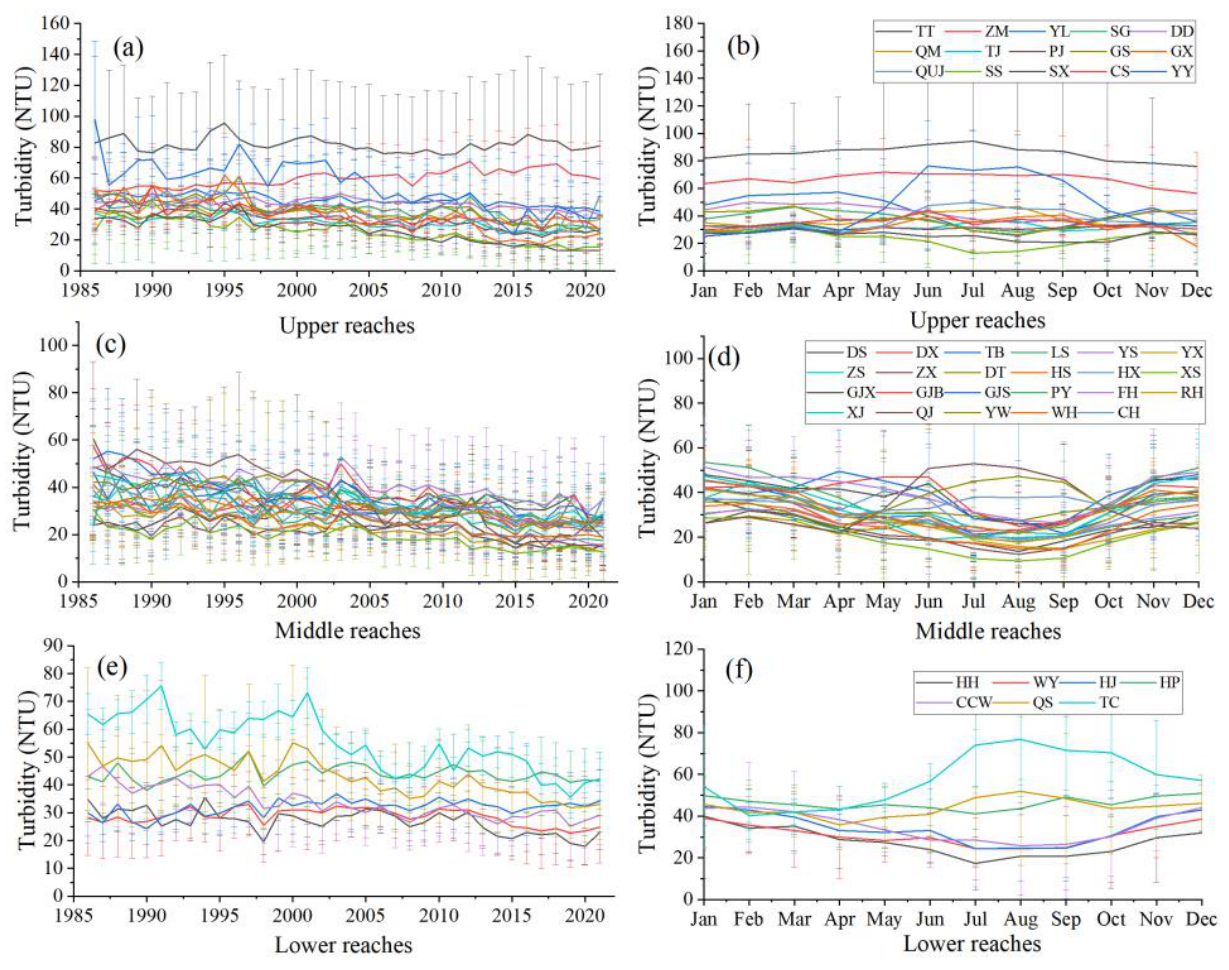
Figure 12. Variations of mean turbidity in tertiary basins in the Yangtze River Basin from 1986 to 2021. ( a ) annual variations in the upper reaches; ( b ) monthly variations in the upper reaches; ( c ) annual variations in the middle reaches; ( d ) monthly variations in the middle reaches; ( e ) annual variations in the lower reaches; ( f ) monthly variations in the lower reaches.